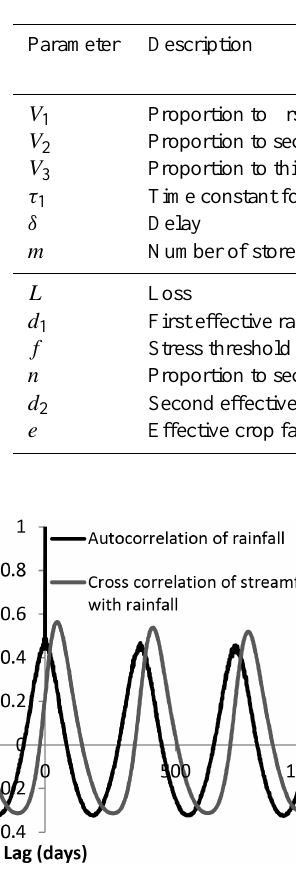
Table 1. Parameter values for the Bani catchment.